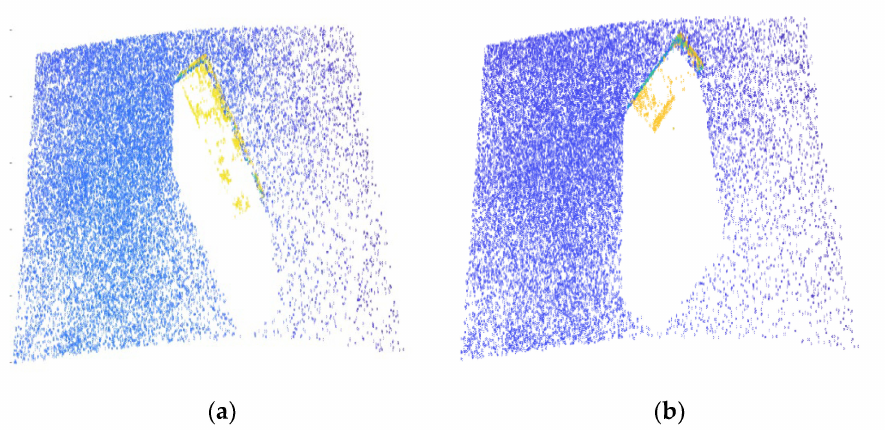
Figure 9. Illustration: ( a ) original 3D point images 1; ( b ) original 3D point images 2. Next, 14 points were selected in order to verify the measurement accuracy of the system. The obtained measurement results were compared with the tape (the minimum scale was 1 mm) and the error was basically controlled within 1%. The results are shown in Tables 4 and 5. Table 4. Measurement accuracy verification of the calibration box image 1.